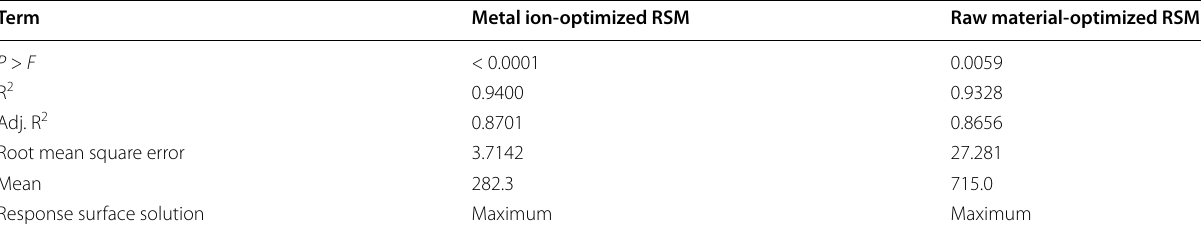
The value of “ P > F ” less than 0.05 indicates the model terms are significant